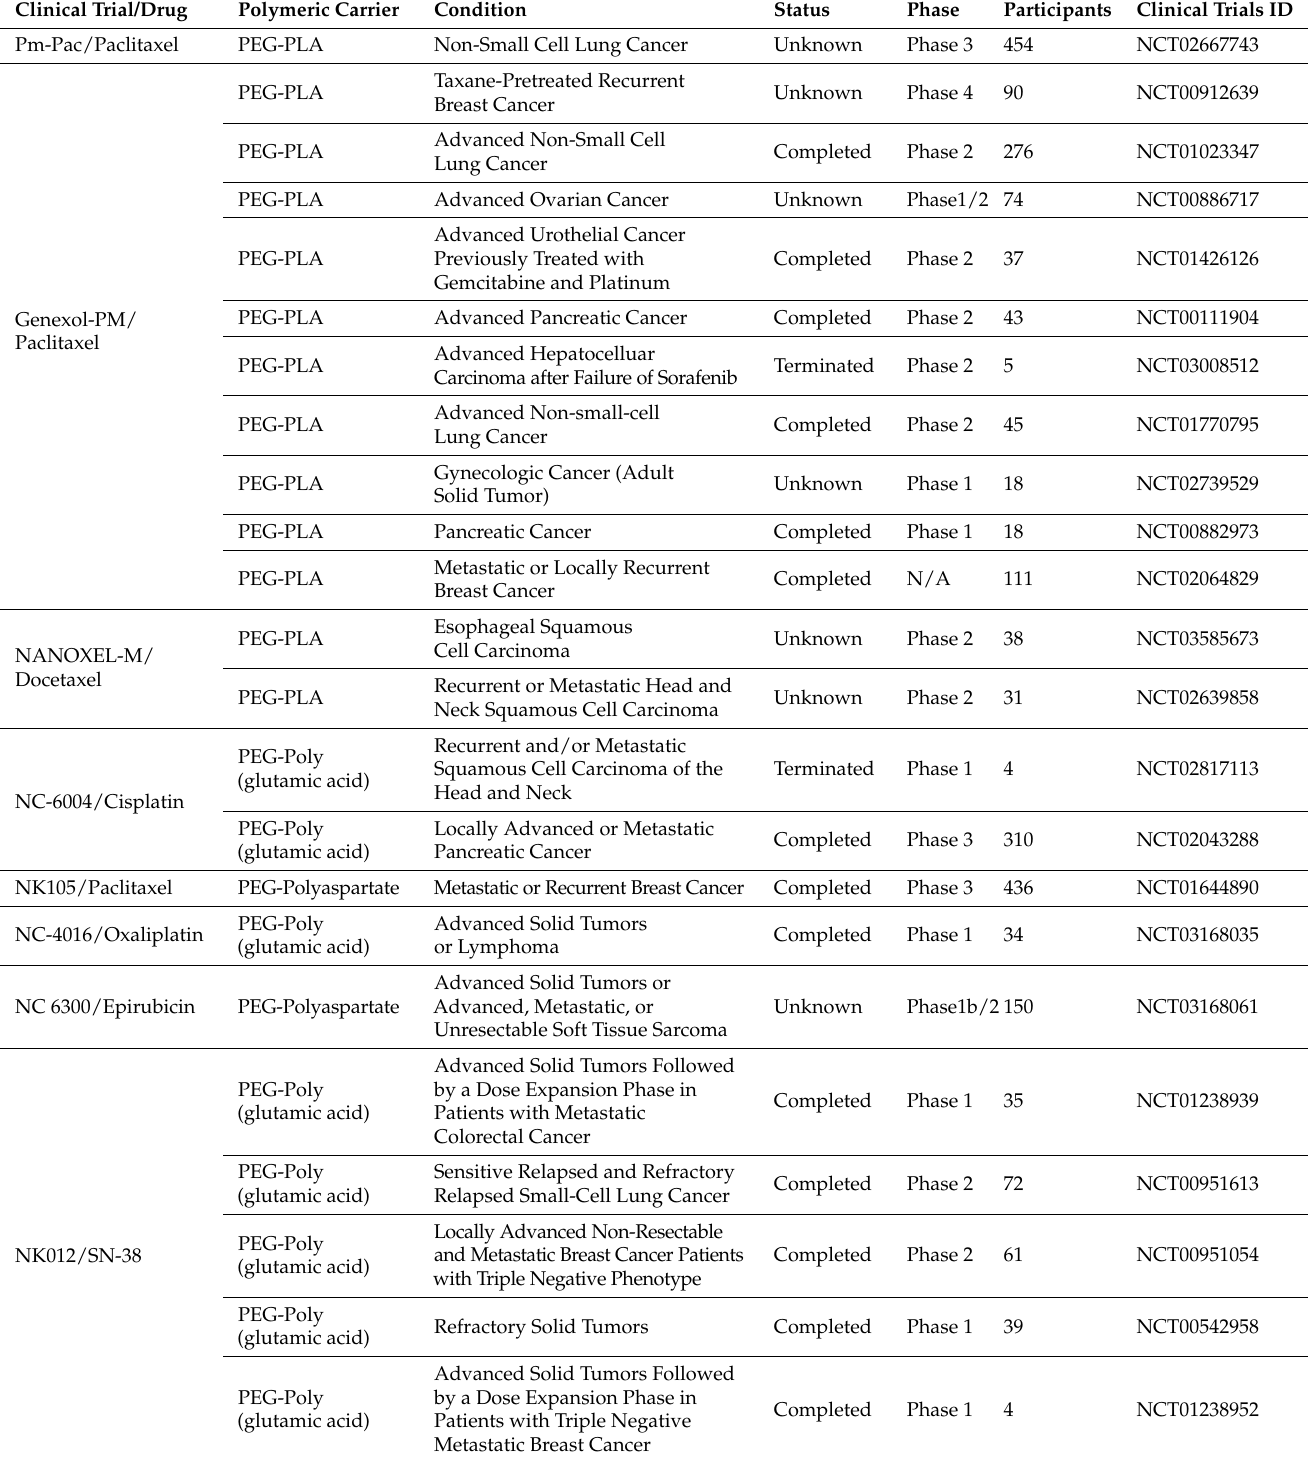
Table 4. The clinical trials of polymeric